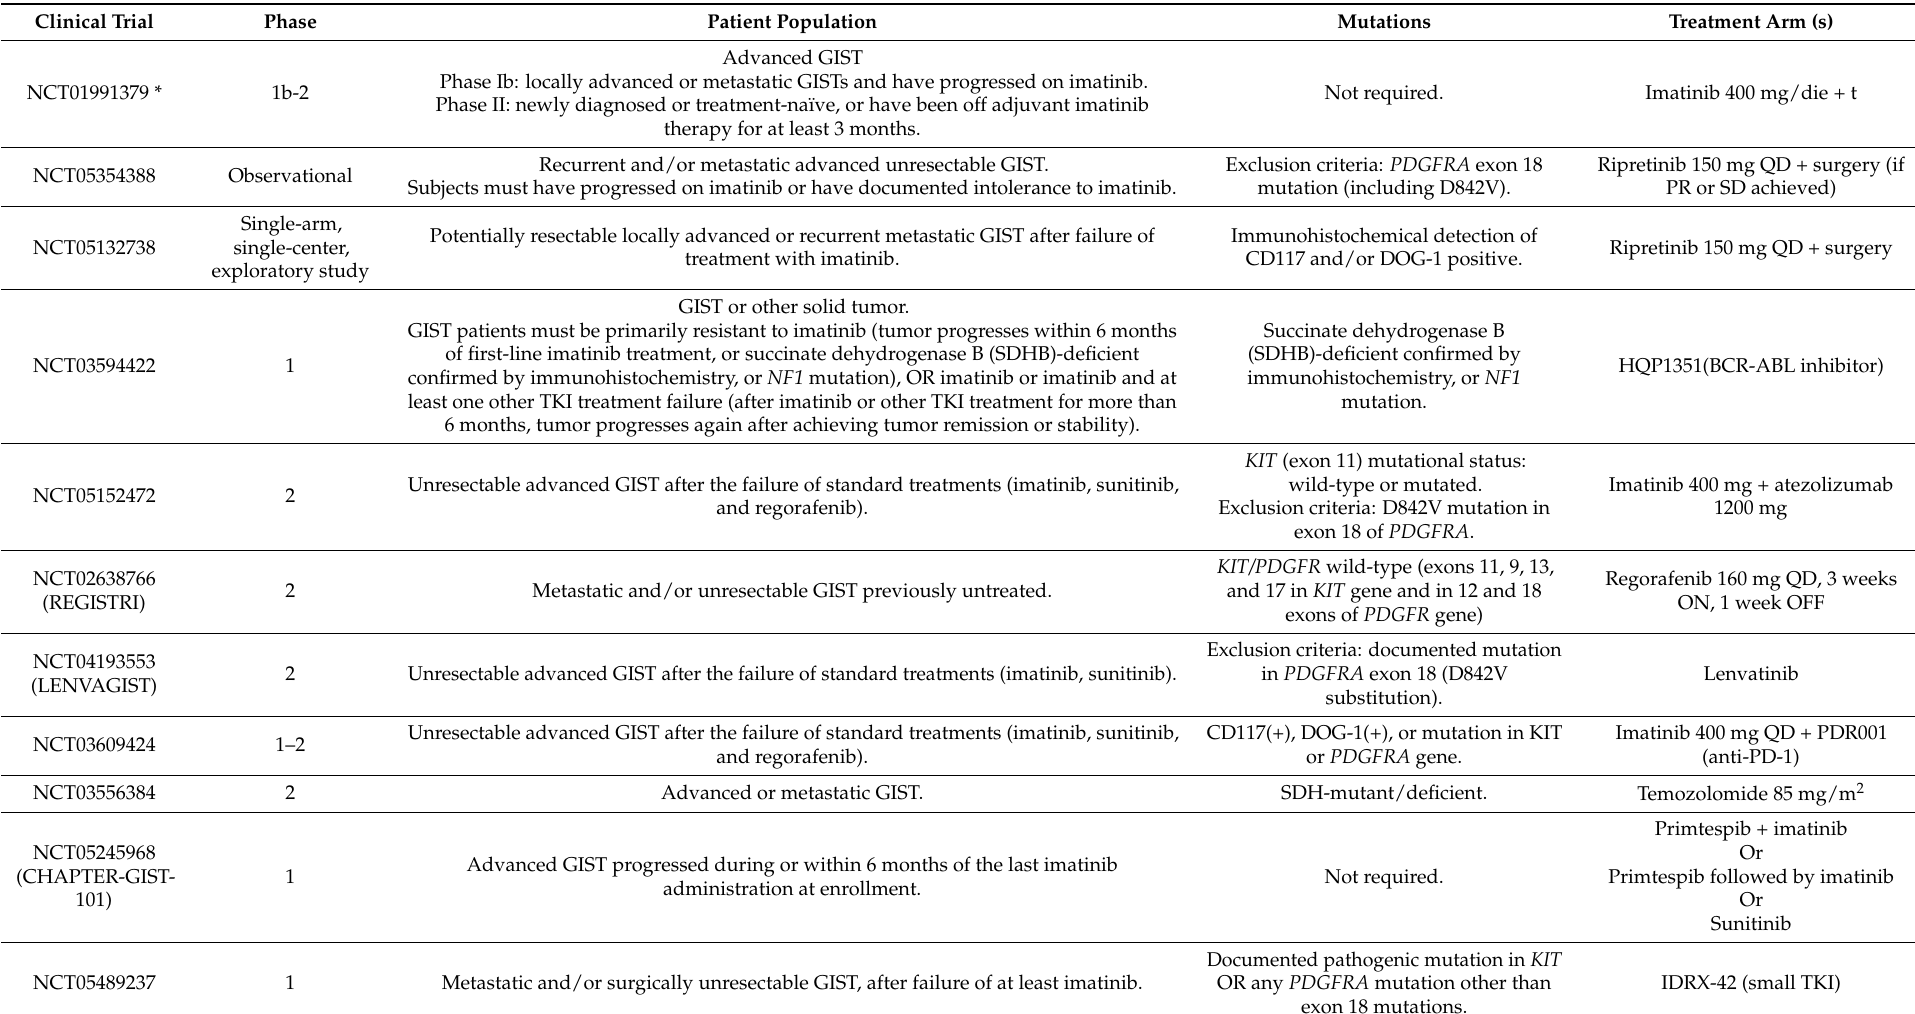
Table 1. Active clinical trials on